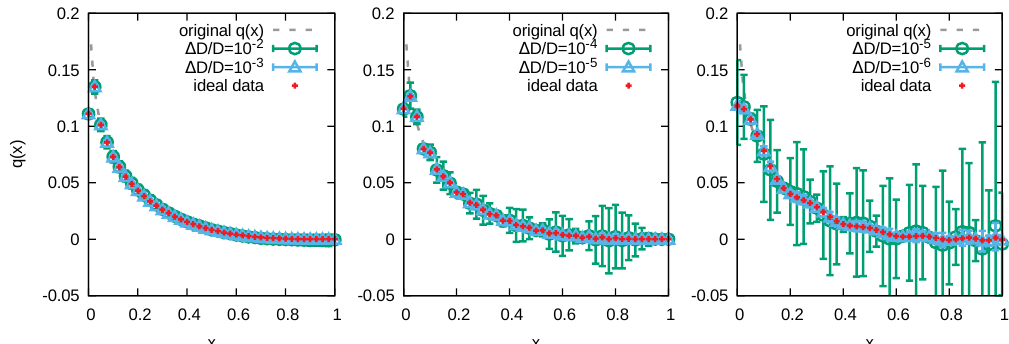
Figure 2 . Direct inversion results for di(cid:11)erent discretization intervals of (cid:23) (left (cid:23) = [0 ; 40 (cid:25) ], center (cid:23) = [0 ; 100], right (cid:23) = [0 ; 20]). The matrix inverse is regularized by retaining only the singular values of C that are larger than 10 (cid:0) 4 . Note the di(cid:11)erent size of the relative errors needed, to